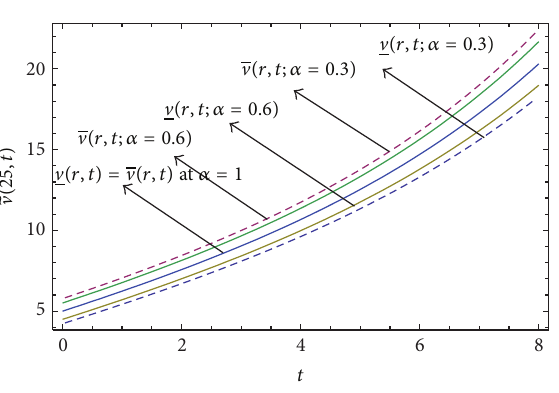
Figure 8: Interval solution of Case